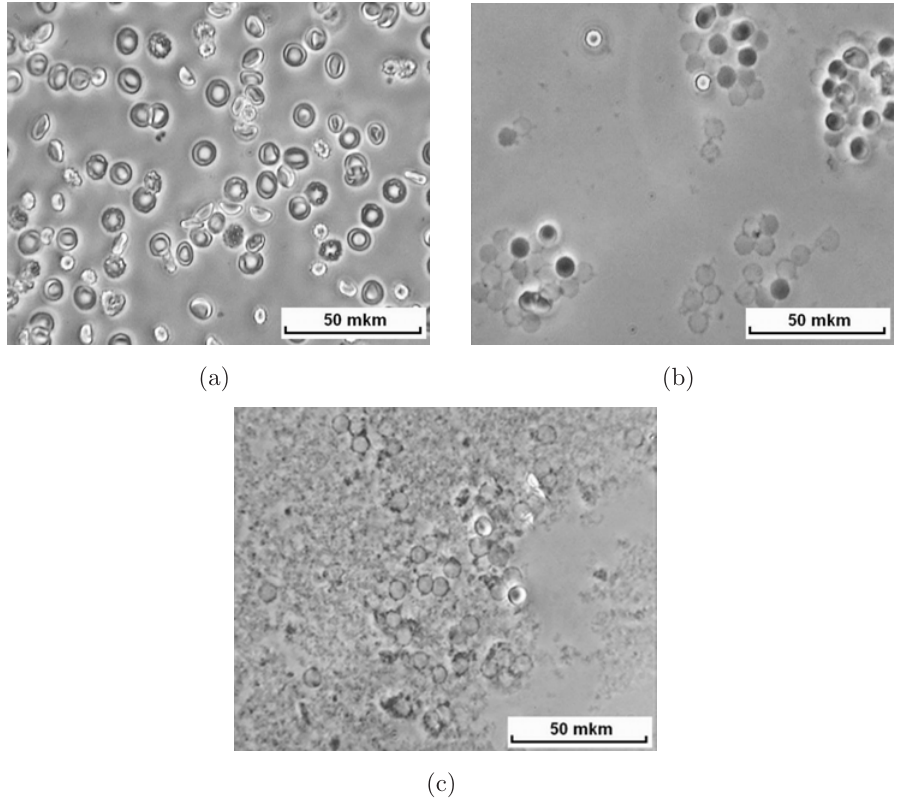
Fig. 2 Microphotographs of RBCs in the buffer suspension of (a) control sample; and with the presence of (b) 0.1 wt.% and (c) 1.0 wt% of unmodified silica A-300.